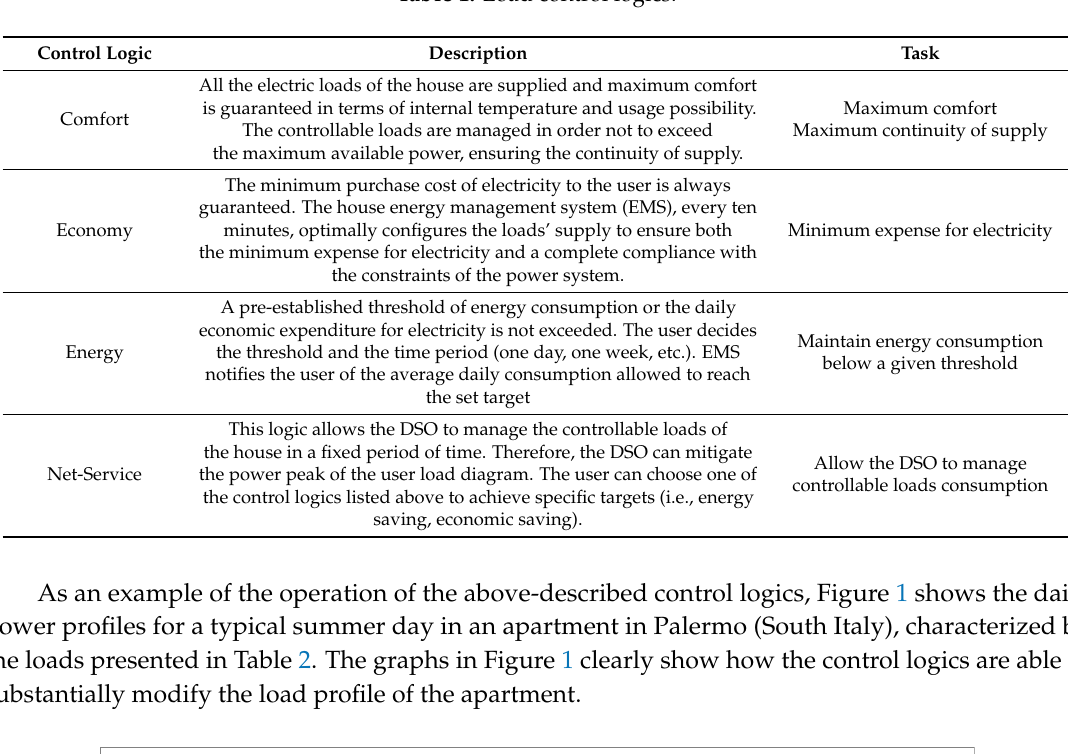
Table 1. Load control logics.